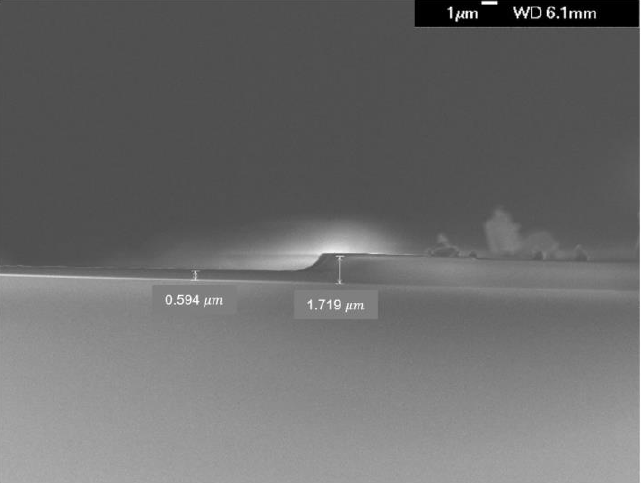
Figure 2. This is an example of removing the PR deposited on the sample.